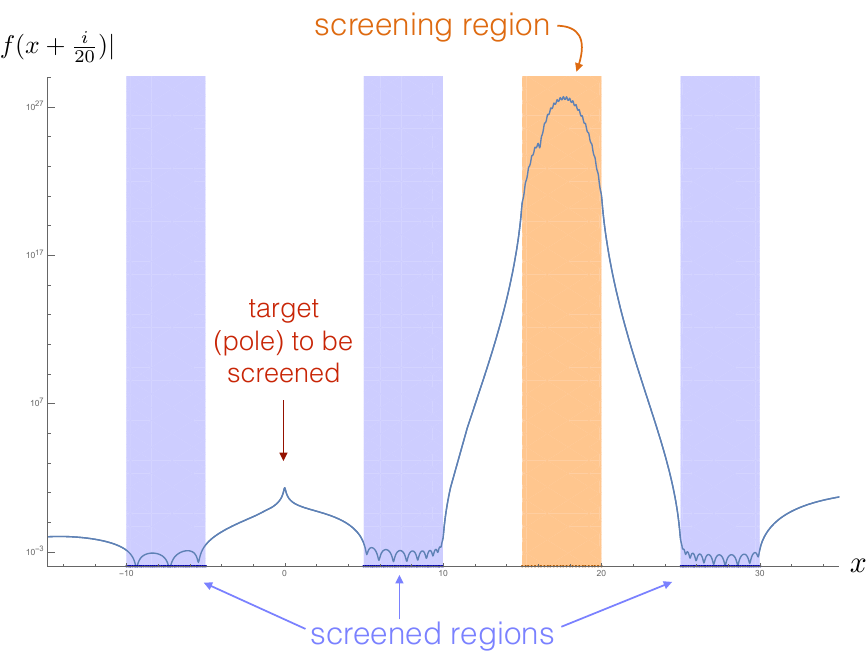
Figure 17. Absolute value of the function f ( x ) de(cid:12)ned in the main text. The pole at the origin can be screened anywhere to any desired accuracy by a simple density in the orange region. The price to pay is that the density there is pretty extreme, (cid:13)uctuating wildly and of huge magnitude. If we have regions where amplitude discontinuities are unbounded, we might expect such screening phenomena to produce such strange behaviour at unphysical regions leading to no